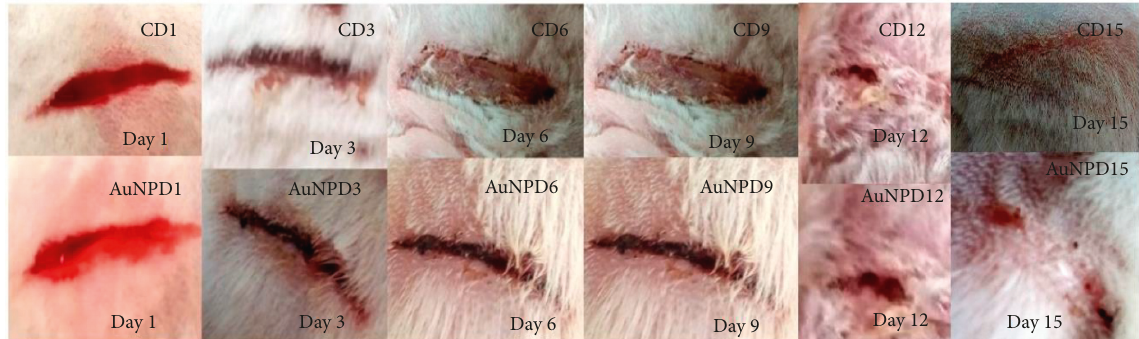
Figure 6: Macroscopic appearance of wounds at various time intervals. CD1, CD3, CD6, and CD9 show experimental wound appearances for control, on day one, three, six, and nine, respectively. AuNPD1, AuNPD3, AuNPD6, and AuNPD9 show wound appearance when treated with Au NPs on day one, three, six, and nine, respectively.